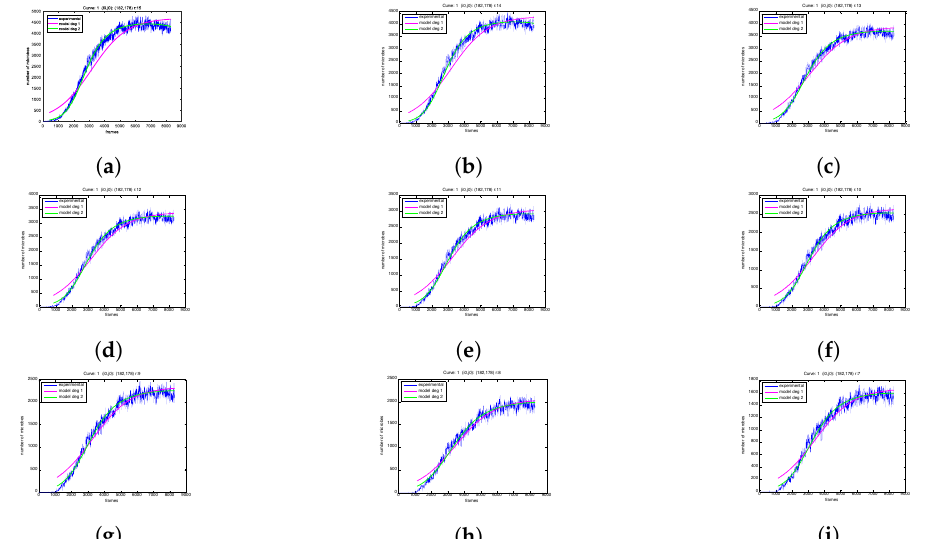
Figure 8. The modeling of the generated experimental curves with LF and LFSD for a different size area r , around the central point. ( a ) r = 15, ( b ) r = 14, ( c ) r = 13, ( d ) r = 12, ( e ) r = 11, ( f ) r = 10, ( g ) r = 9, ( h ) r = 8, ( i ) r = 7.